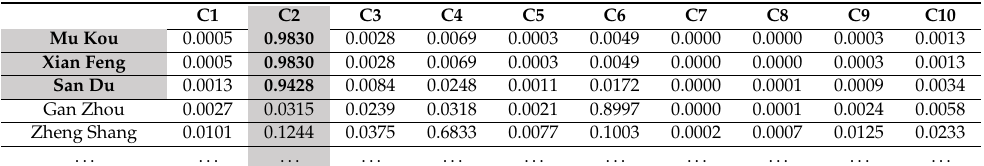
Table 6. Clustering results after SC-FCM clustering fusion (C represents